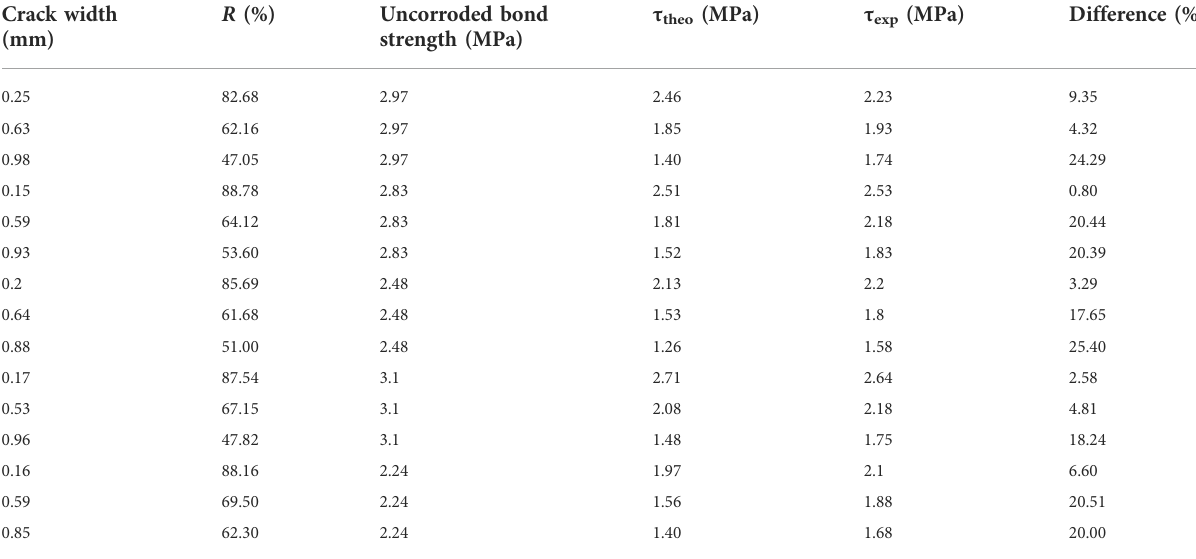
TABLE 9 Validation of the proposed model with Haddad and Al-Dalou (2018) based on maximum crack width. R Crack width (mm)